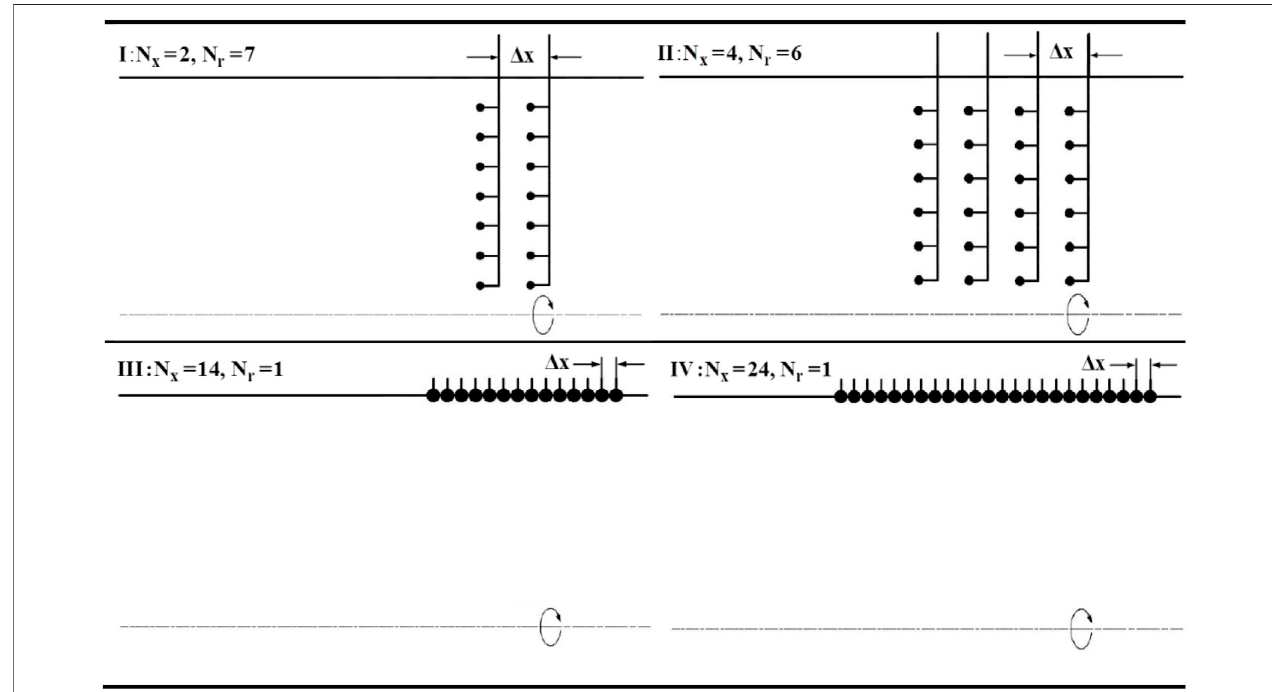
FIGURE 1 | Sensor array schemes A-I to A-VI: N x N r (cid:2) 14 in the left column; N x N r (cid:2) 24 in the right column.